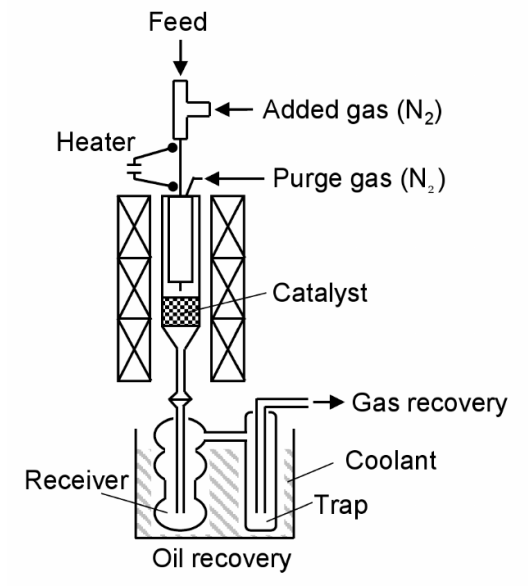
Figure 8. Schematic representation of the microactivity test